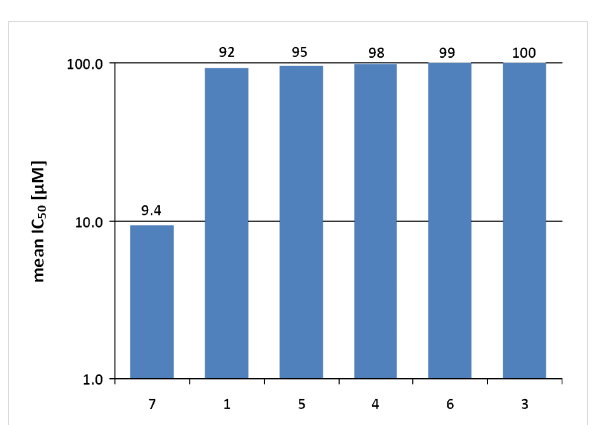
Figure 12: In vitro antitumor activity of compounds 1 , 3 – 7 toward 11 human tumor cell lines.